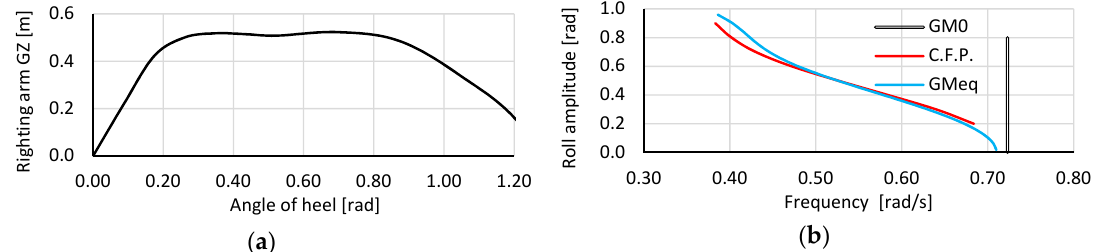
Figure 2. The GZ curve ( a ) and the resonance frequency curve ( b ) for the offshore support vessel ( T = 6.10 m, GM 0 = 2.50 m).